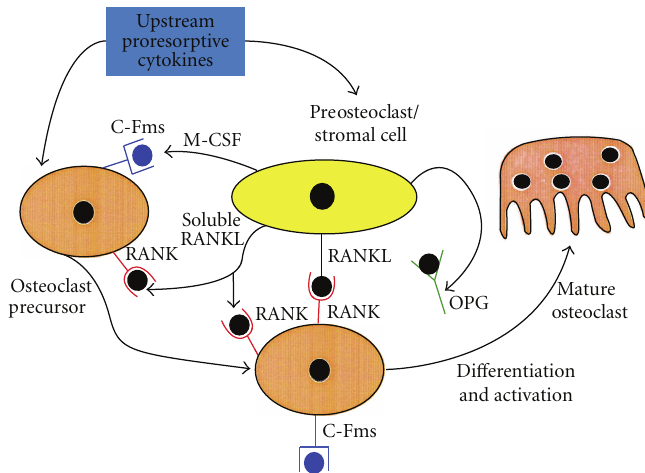
Figure 2: Regulatory mechanisms of osteoclastogenesis [22].